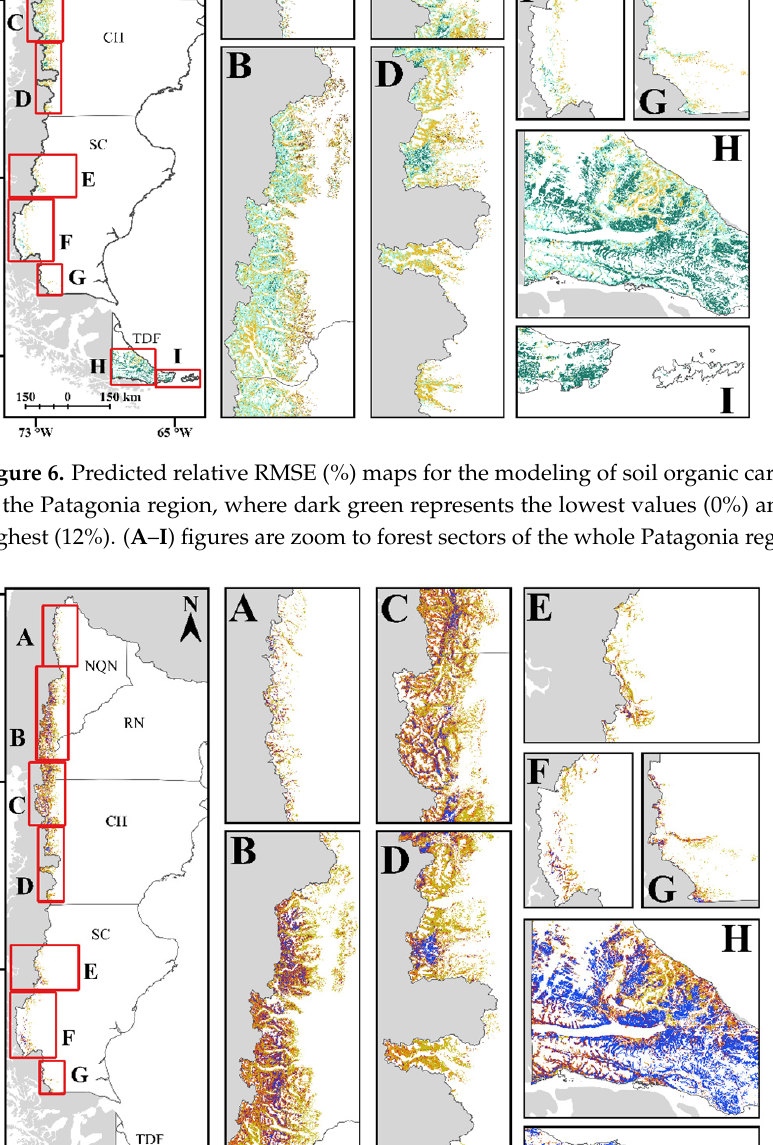
Figure 7. Predicted absolute RMSE (ton C ha − 1 ) maps for the modeling of soil organic carbon content